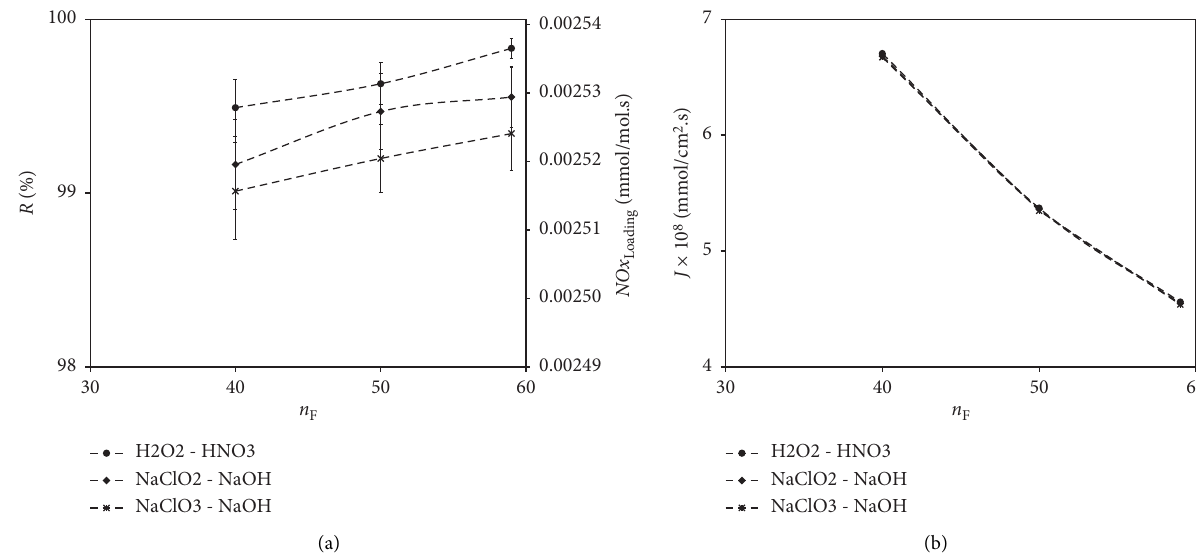
Figure 6: The effect of the fiber number in the membrane module, n F , on (a) the NOx expulsion efficiency, R , and NOx loading; (b) the overall mass transfer coefficient, K G , and flux, J , in a membrane module having 400mL of absorbent pairs of H 2 O 2 (0.05 M) - HNO 3 (0.25 M), NaClO 2 (0.05 M) – NaOH (0.25 M), and NaClO 3 (0.05M) – NaOH (0.25 M) at 125mL/min feed gas rate.